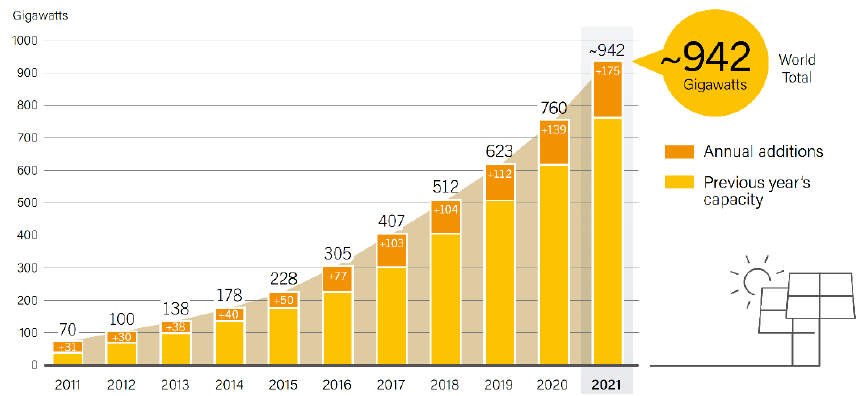
Figure 4. Exponential growth of PV energy in the years 2011 – 2021 (source [11]).